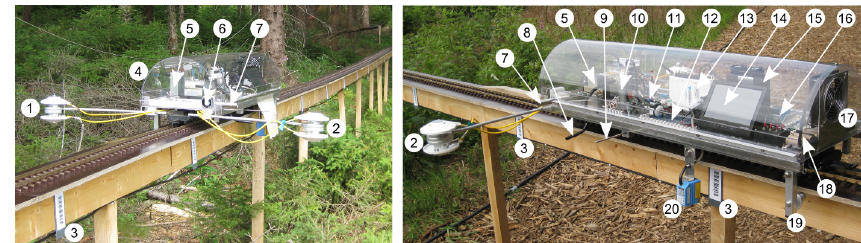
Figure 1. Front and lateral view of the HMMS. Specifications of the numbers are in Table 1. Table 1. Specification of numbers from Fig.